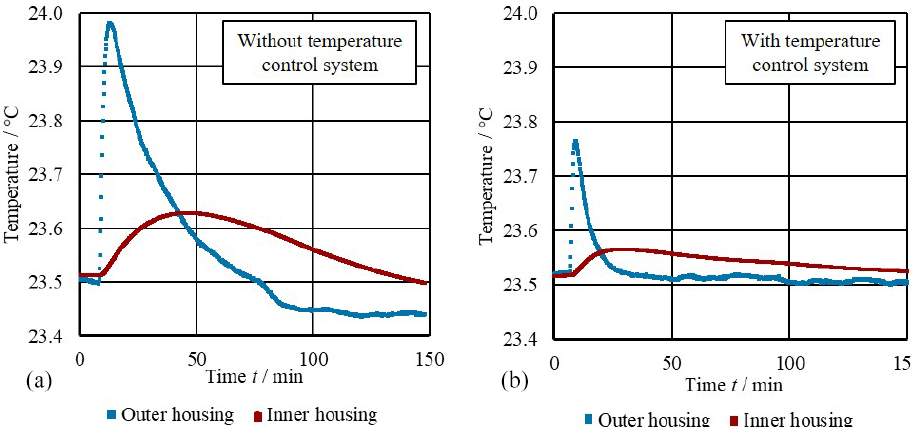
Figure 11. Recorded temperature of outer and inner housing for a thermal disturbance at time t = 10min. The thermal disturbance is simulated by touching the outer housing cover for 1min by hand. The experiment has been conducted with a disabled (a) and activated external temperature control system (b) . The temperature of the outer housing has been measured with a Pt100 sensor and the temperature of the inner housing with the thermistor at the